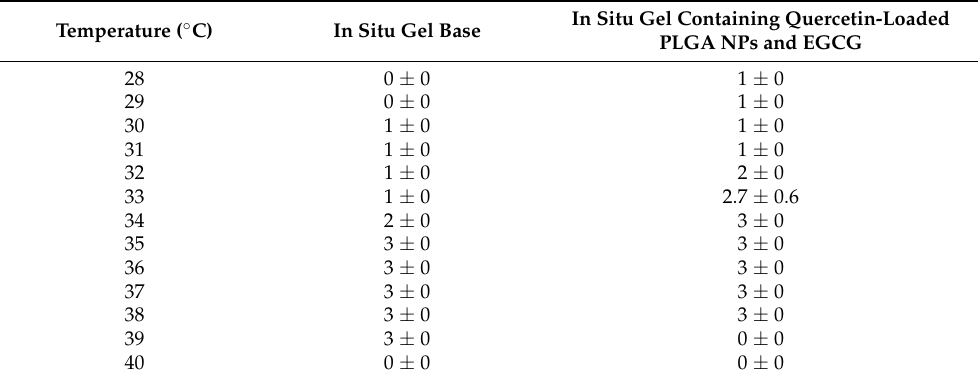
Table 1. Mobility of the in situ thermosensitive gel containing quercetin-loaded PLGA NPs and EGCG upon increasing the temperature.